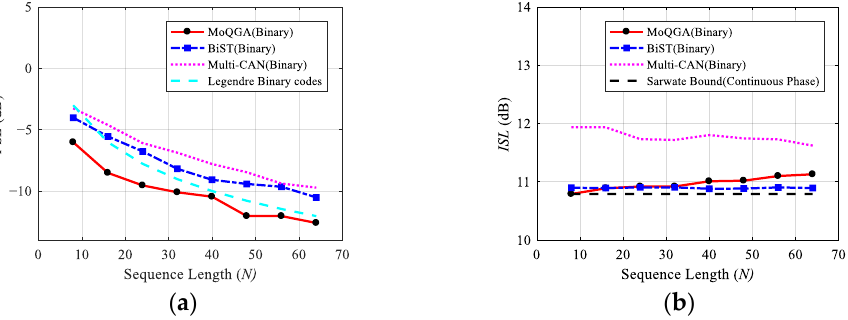
Figure 9. PSL and ISL values of MIMO radar binary phase code sequence set obtained by MoQGA and other methods under M = 4 and different code sequence length. ( a ) PSL ; ( b ) ISL .